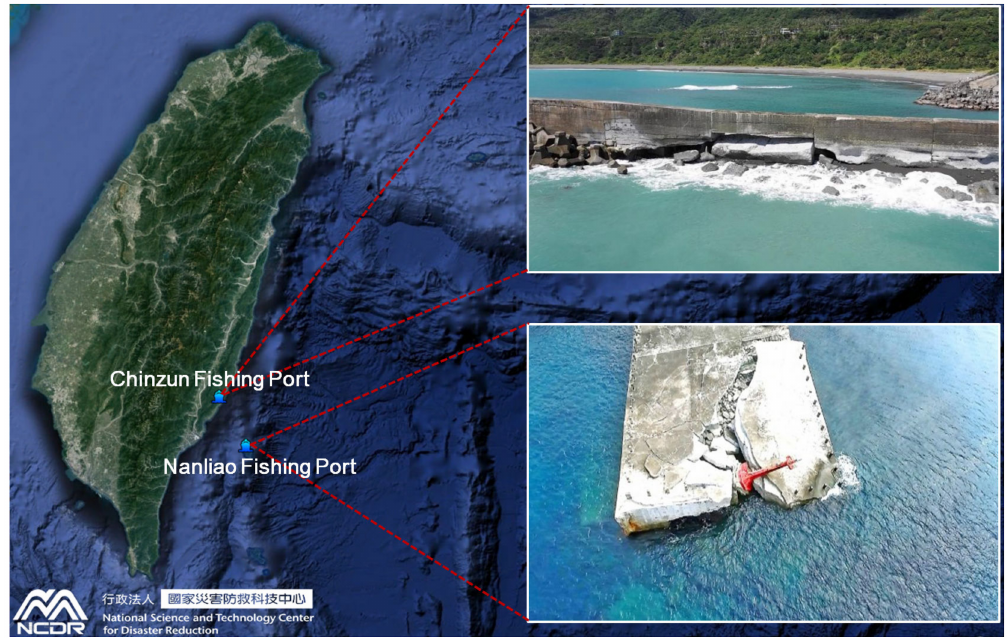
Figure 1. Typhoon-driven storm waves breached a sea wall (upper-right panel) and damaged a lighthouse (lower-left panel) in the southeastern waters of Taiwan (photo by the present